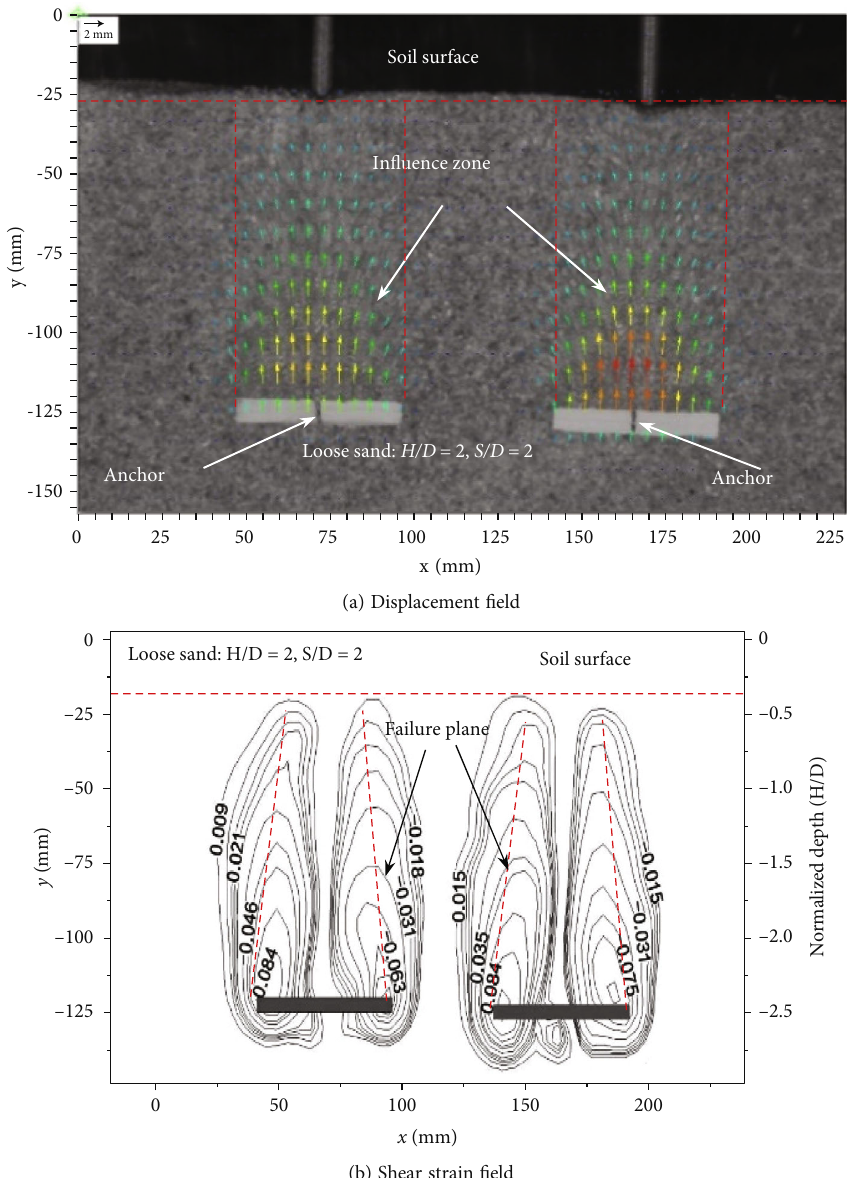
Figure 5: Soil displacement and shear strain fi elds for shallow group anchors in loose